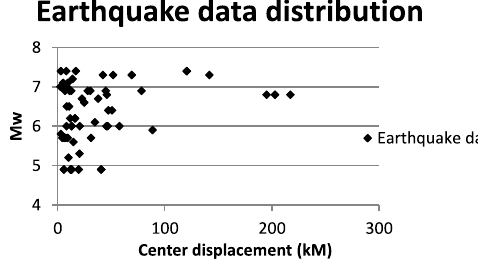
Figure 3. Earthquake data distribution.